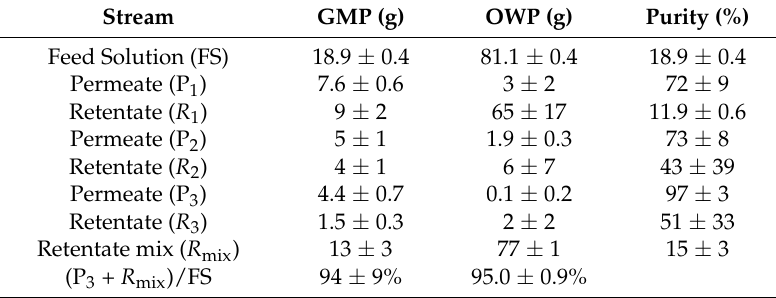
Table 4. Mass balances for GMP and the OWP, and purity of GMP for the three-stage flow configuration evaluated in this